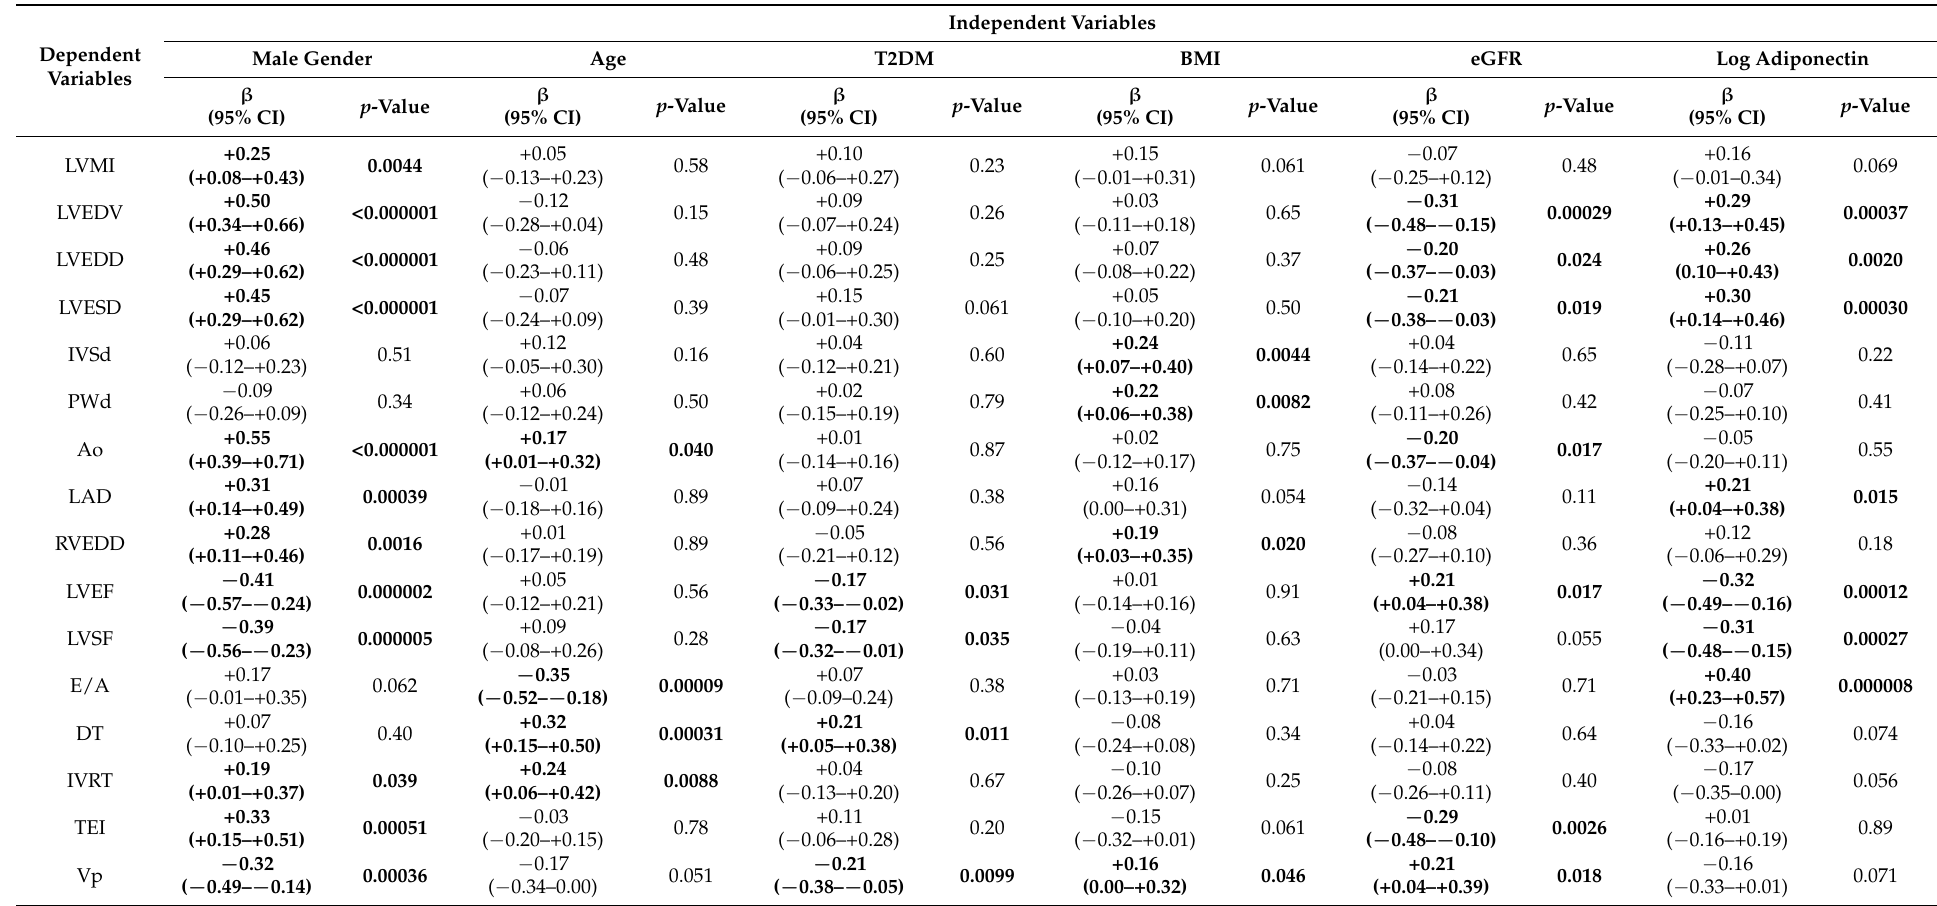
Table 3. Multivariate linear regression models for echocardiography parameters as dependent variables and male gender, age, T2DM, BMI, eGFR and logarithm of plasma adiponectin concentration as independent